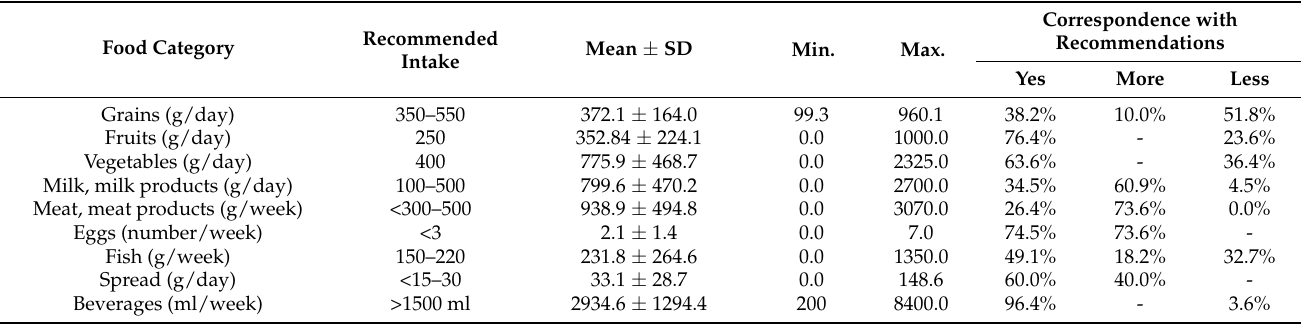
Table 3. Recommendations for dietary intake [31,34] and actual intake by